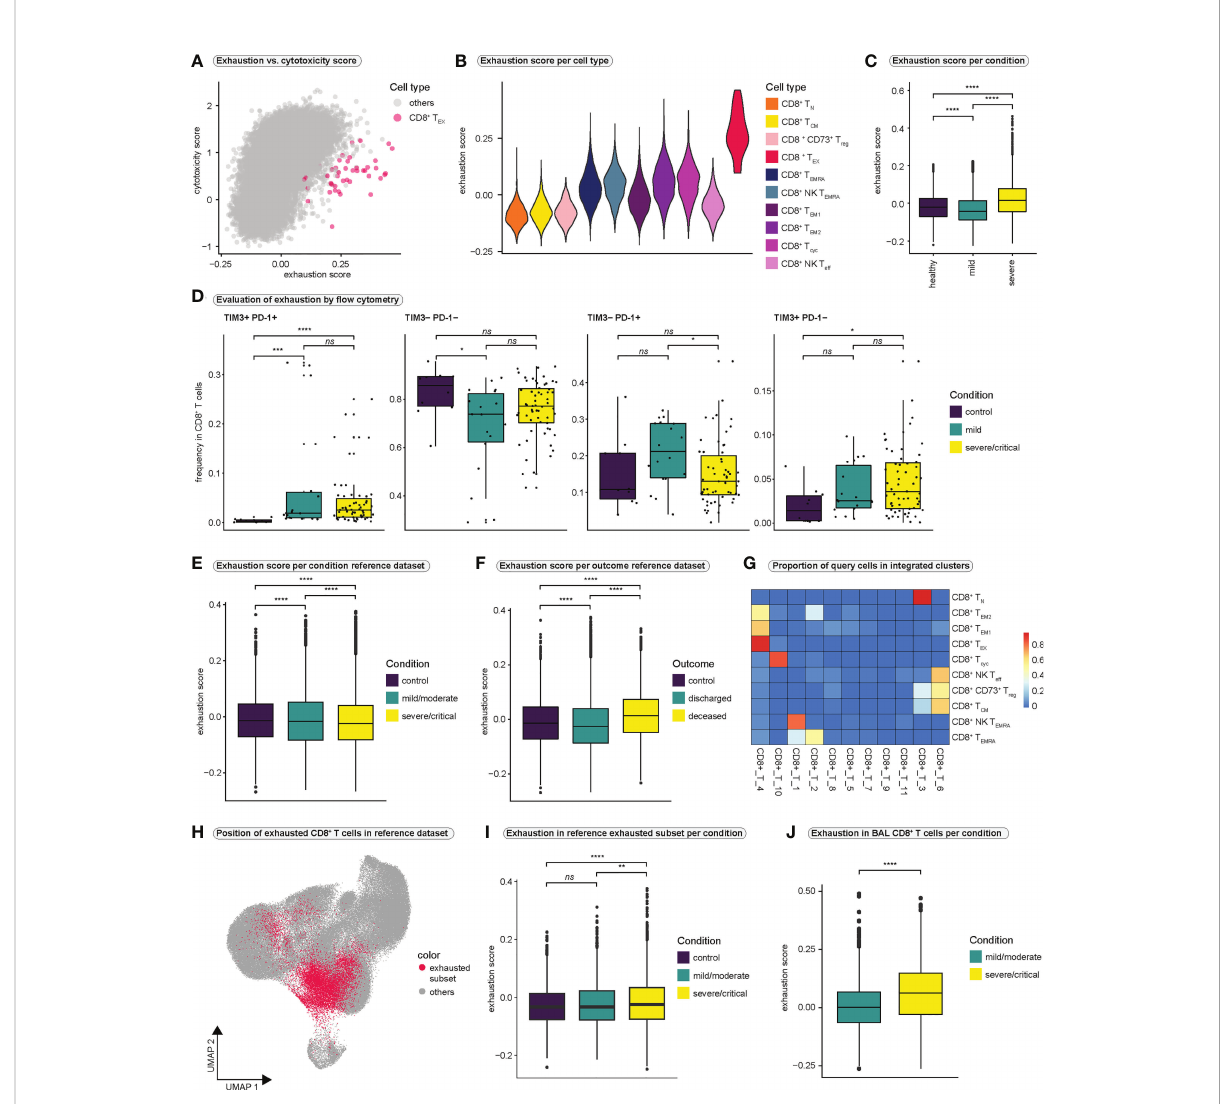
FIGURE 2 CD8 + T cell exhaustion in COVID-19 (A) Relationship between T cell exhaustion and cytotoxicity. Each CD8 + T cell is placed in the coordinate system according to its individual exhaustion and cytotoxicity score value. To highlight the position of CD8 + exhausted T cells, all other CD8 + T cell populations are colored in gray. A version of this plot with cell type-speci fi c and condition-speci fi c colors is available in Figure S2A, S2B, respectively. (B) Violin plot of exhaustion scores per cell type. (C) Exhaustion scores in all CD8 + T cells per condition. (Kruskal-Wallis test: H (2 ) = 2407, p < 0.0001; healthy vs. mild: p < 0.0001; healthy vs. severe: p < 0.0001, mild vs. severe: p < 0.0001) (D) Frequencies of cells expressing different combinations of the exhaustion markers PD-1 and TIM3 in all CD8 + T cells as examined by fl ow cytometry. (TIM3 + PD-1 + :